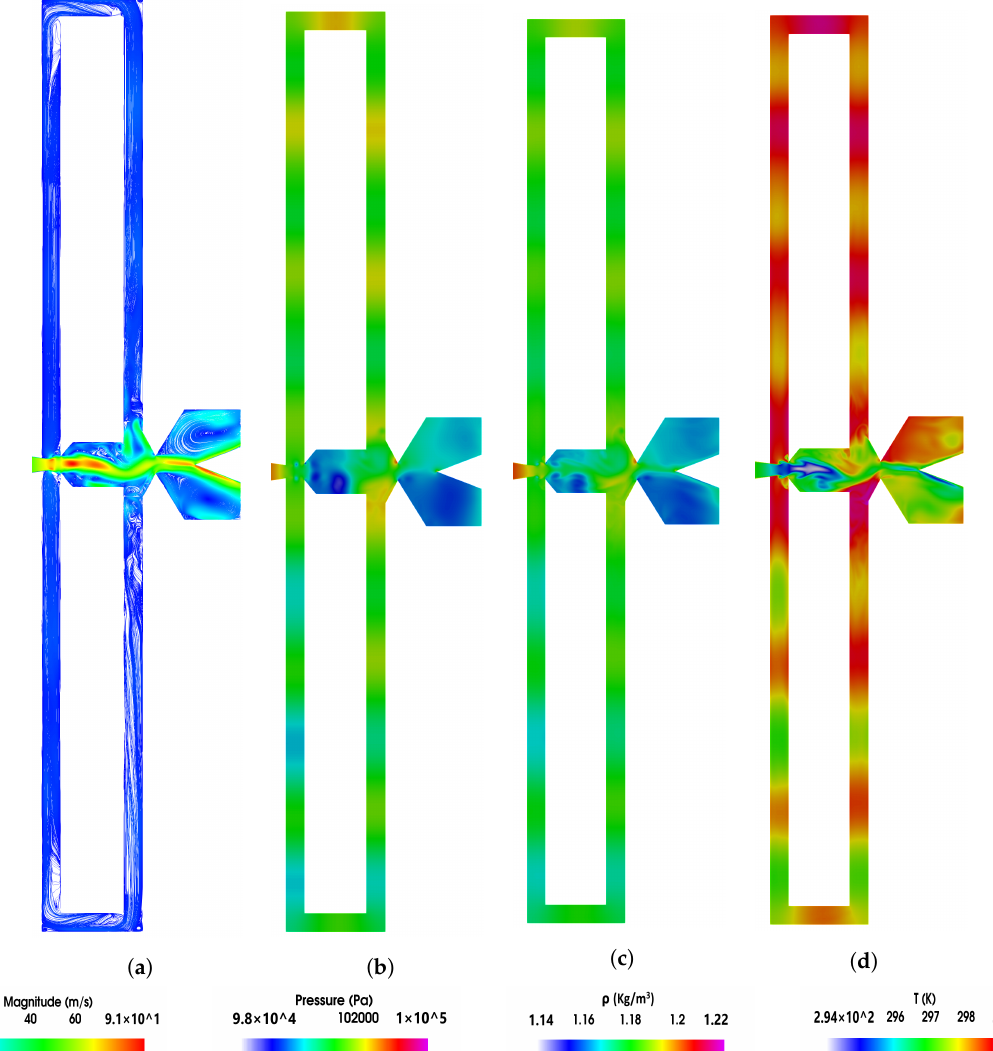
Figure 15. Feedback channels and mixing chamber instant velocity, pressure, density and temperature fields. Power nozzle velocity, 65 m/s, feedback channel length,